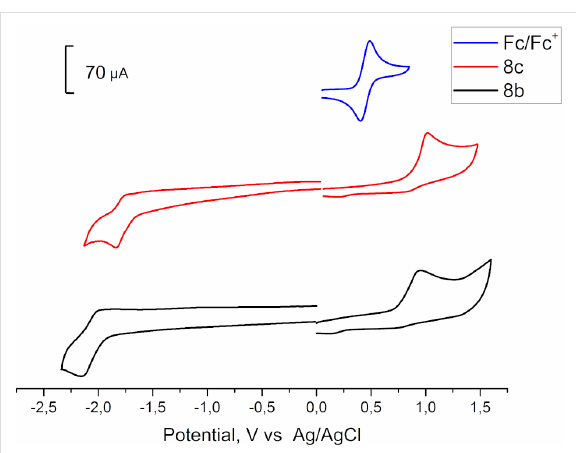
Figure 5: Cyclic voltammograms of 3,4,5-triaryl-1,2-diphosphafer- rocenes 8b and 8c in CH 3 CN on glassy carbon electrode (0.5 mM complex). Potentials vs Ag/AgCl. Scan rate = 100 mV ⋅ s − 1 , room tem- perature. Cyclic voltammogram of 8c republished with permission